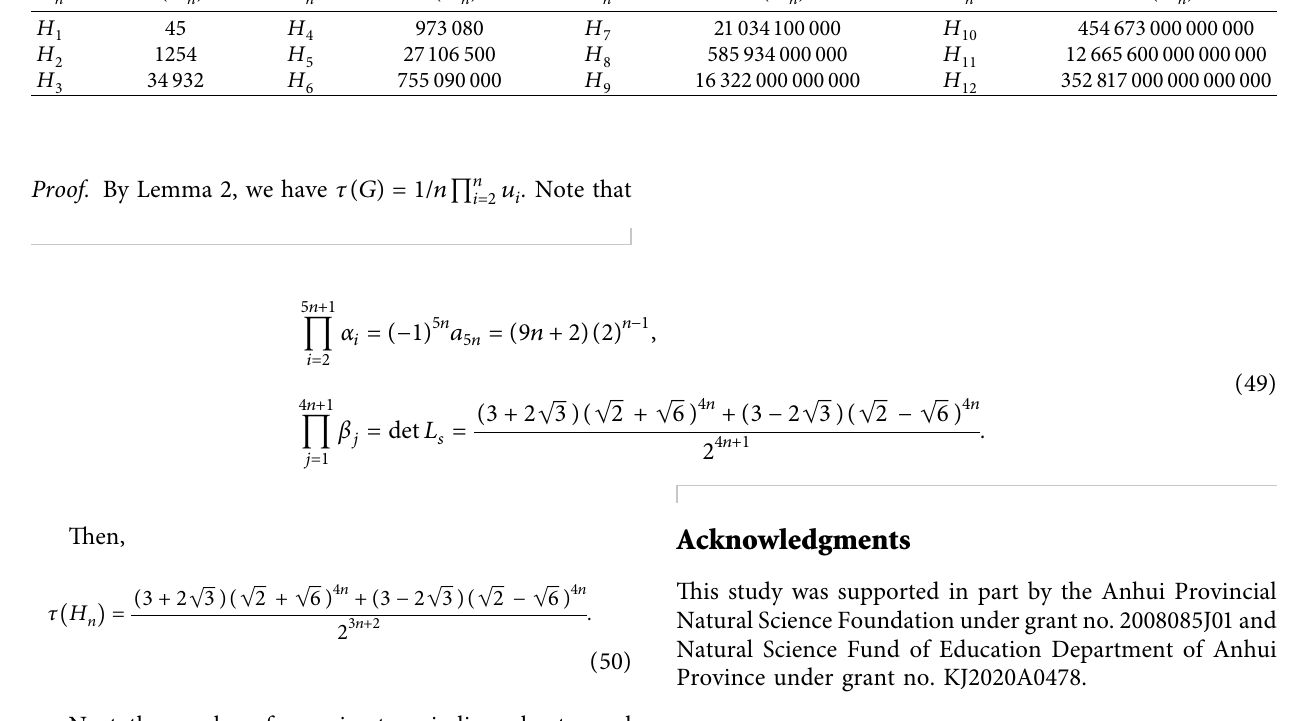
Table 2: The number of spanning trees of linear heptagonal networks from H